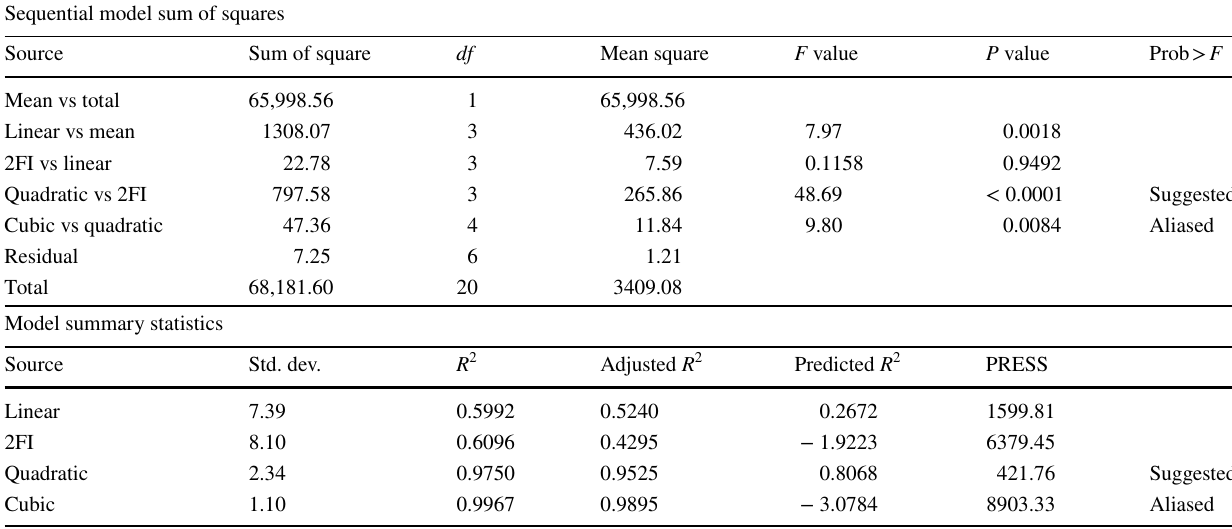
df degree of Table 5 Sequential model sum of squares and model summary statistics for percentage TOC removal (%) model sum of squares